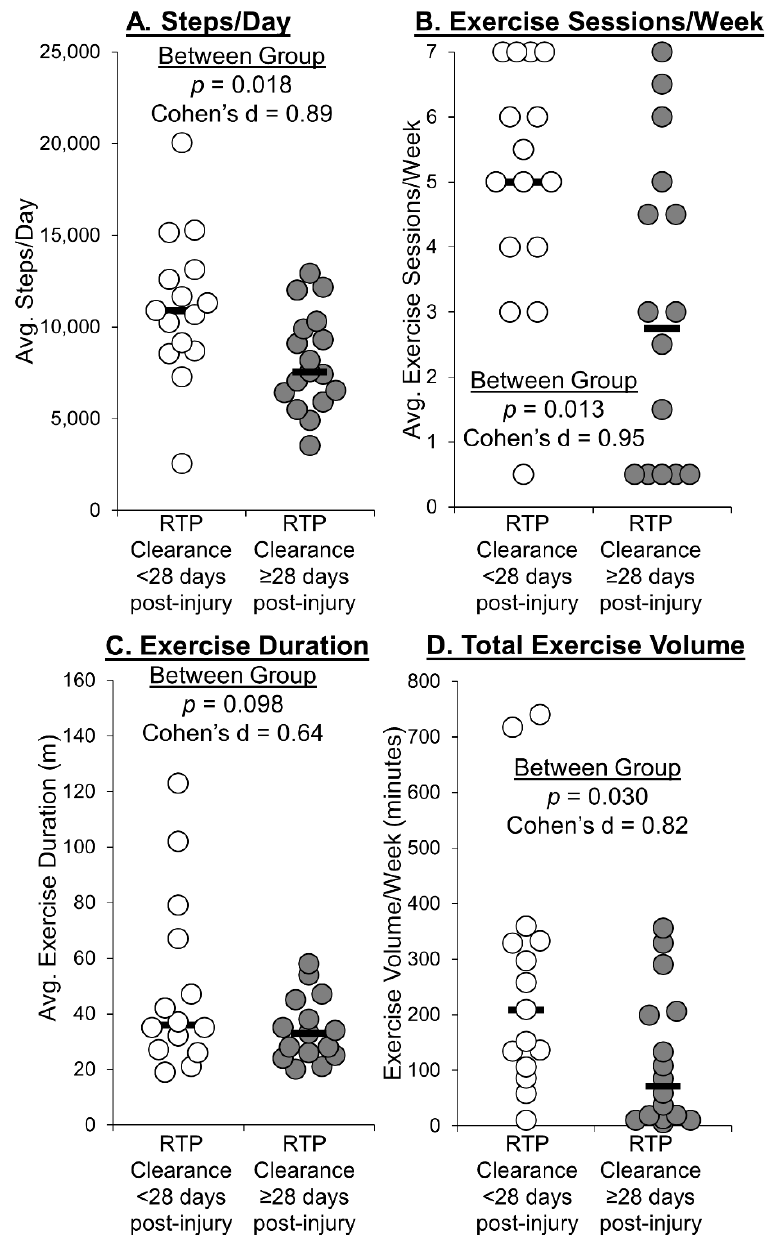
Figure 1. Individual data points describing the exercise characteristics ( A ) average steps per day; ( B ) average exercise sessions per week; ( C ) average duration when exercising; ( D ) average total exercise volume per week. across the two weeks after study enrollment between those who received RTP clearance 28 days or greater post-injury compared to those who received RTP clearance in less than 28 days post-injury. Black bars represent the group mean.